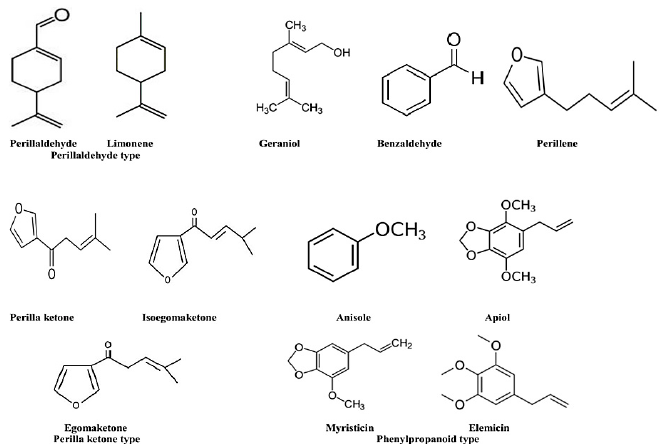
Figure 2. The chemical structures of some volatile compounds identified in P. frutescens ; perillaldehyde, limonene, geraniol, perillene, benzaldehyde, perilla ketone, isoegomaketone, anisole, apiol, egomaketone, myristicin, elemicin.